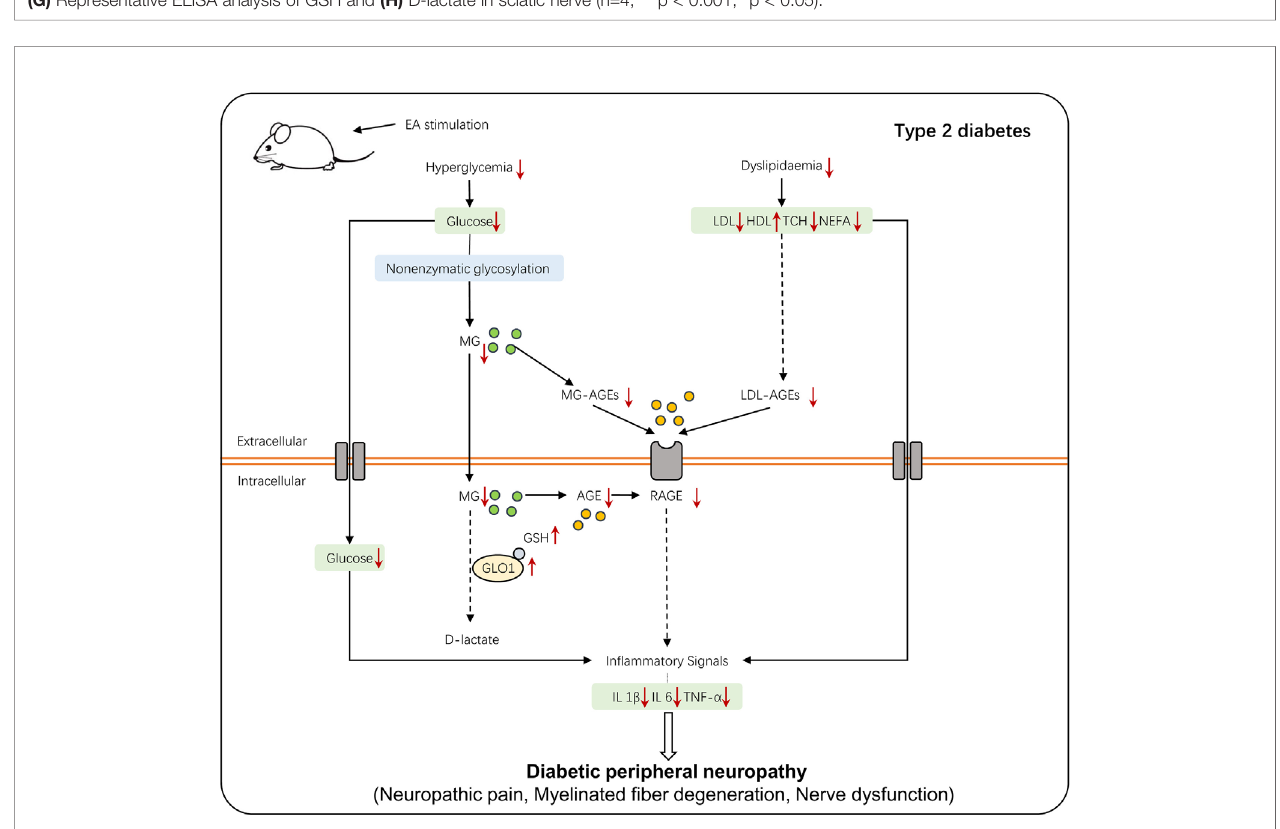
FIGURE 7 | The schematic diagram of EA stimulation on T2DM-induced peripheral neuropathy. T2DM-induced hyperglycemia and dyslipidemia lead to the accumulation of AGEs and interaction of AGE-RAGE, which alters a series of in fl ammatory signals and eventually causes DPN. EA stimulation regulates glycolipid metabolism, which then activates the glyoxalase system and enhances MG detoxi fi cation, alleviating the hyperalgesia of